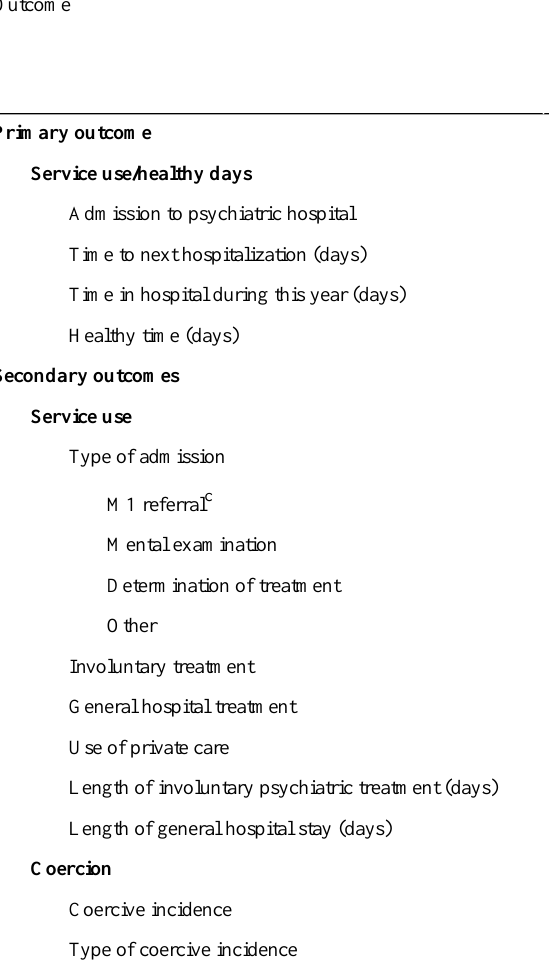
Table 2. Dummy table for primary and secondary outcomes and end points. ControlInterventionOutcome